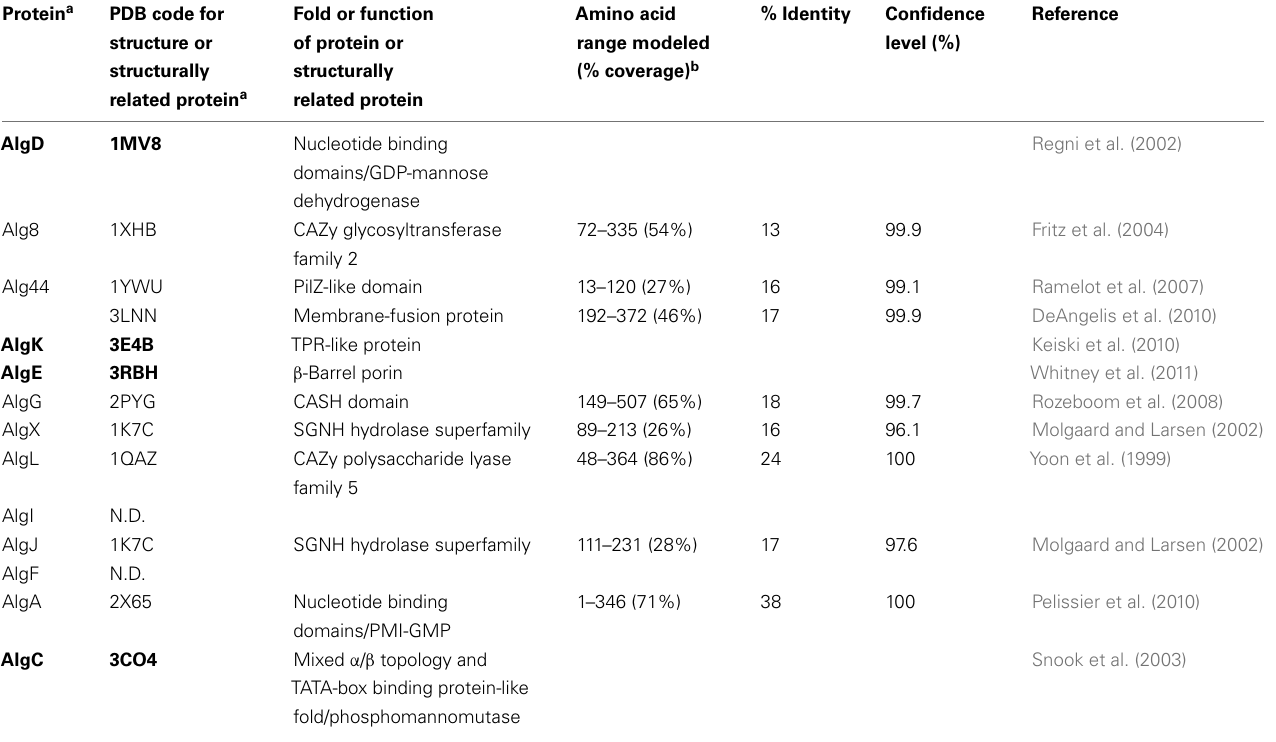
a Bold letters indicate that the structure has been experimentally determined. b Extent of the alginate protein